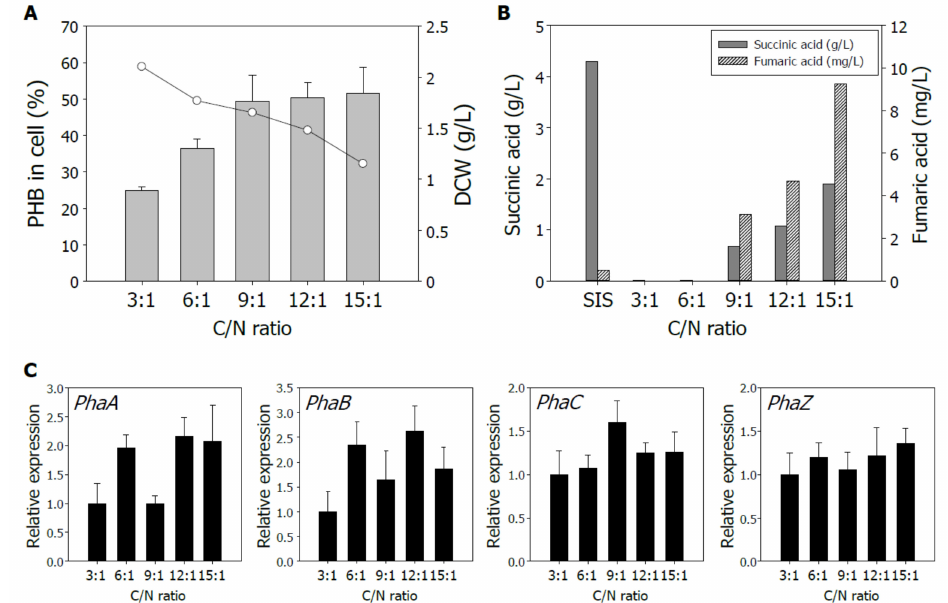
Figure 4. E ff ects of carbon to nitrogen ratio on PHB production in R. sphaeroides . ( A ) PHB accumulation (% of dry cell weight) and cell growth under indicated C / N ratio. The cells were grown under dark-aerobic conditions and harvested at 48 h after inoculation. Gray bars for PHB contents and open circle lines for DCW. ( B ) Measurement of organic acids concentrations. ( C ) Expression of genes encoding PHB biosynthetic enzymes. Experiments were performed in triplicate and bars indicate standard error of the mean. Asterisks represent statistically significant di ff erence, as determined by a Student t